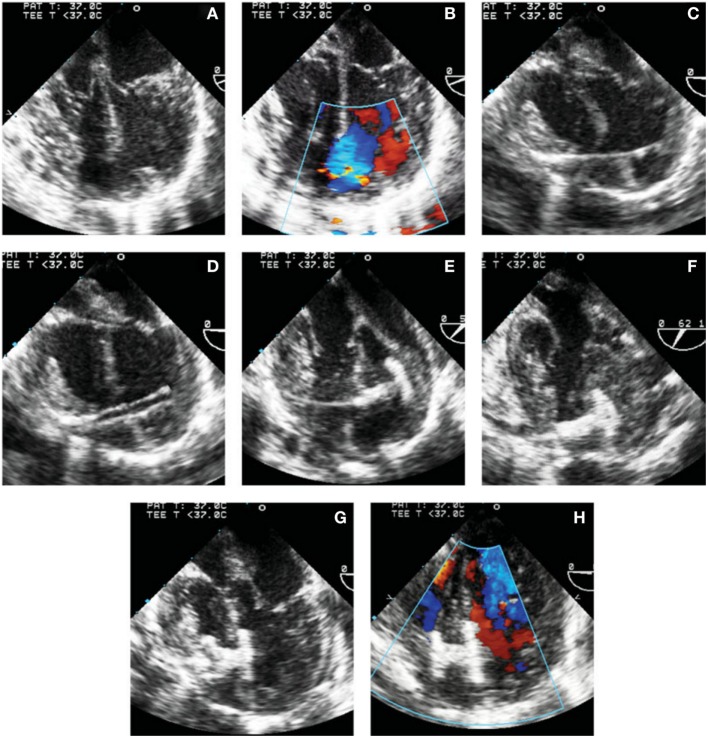
Transesophageal echocardiographic images of steps involved in perventricular ventricular septal defect (VSD) closure. (A,B) 4-chamber view without (A) and with (B) color Doppler showing the mid muscular VSD. (C) Wire through the right ventricular free wall and across the defect. (D) Delivery sheath in the left ventricle (LV) cavity. (E) Left disk deployed in the LV. (F) Left disk aligned with the ventricular septum. (G) Device waist and part of the right disk have been deployed. (H) Complete deployment of the right disk with optimal device position. Reprinted with permission from publisher: John Wiley and Sons (29).